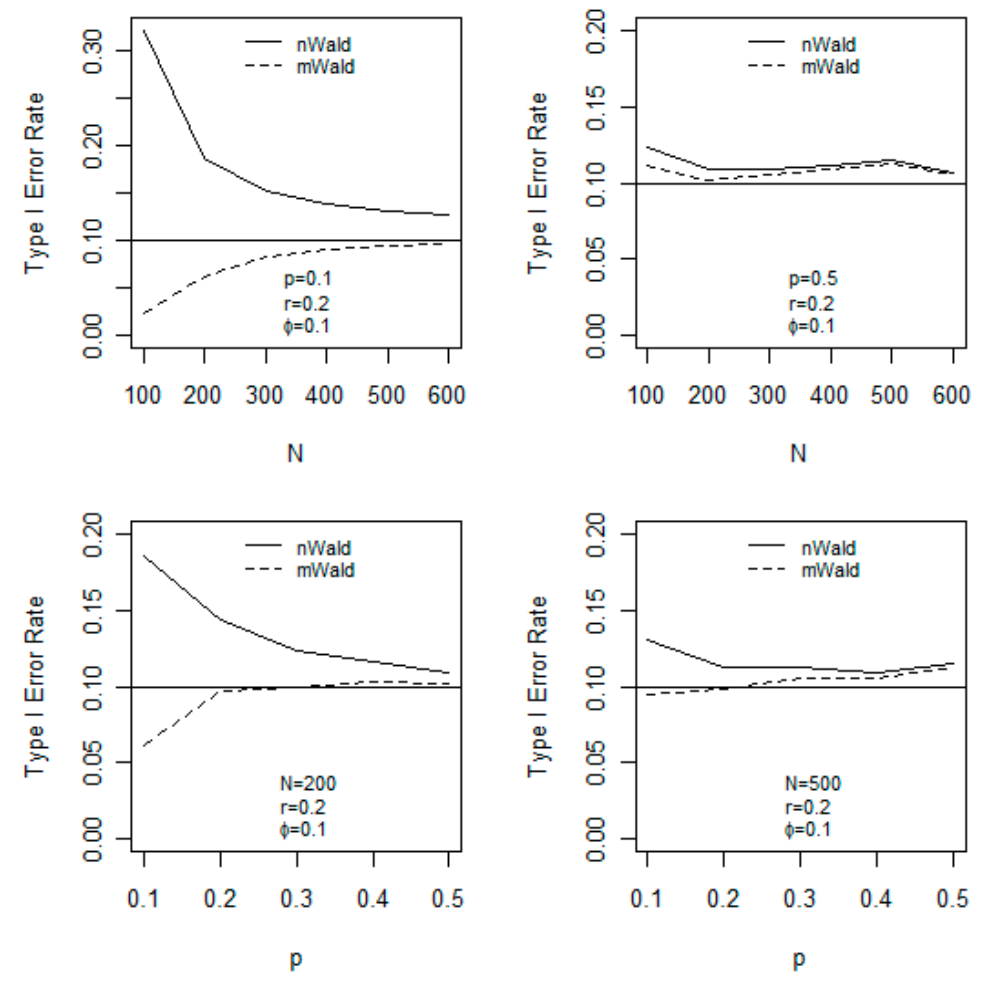
Figure 2. Type I error rate versus total sample sizes N for the upper two panels and versus the true proportion parameter p for the lower two panels.